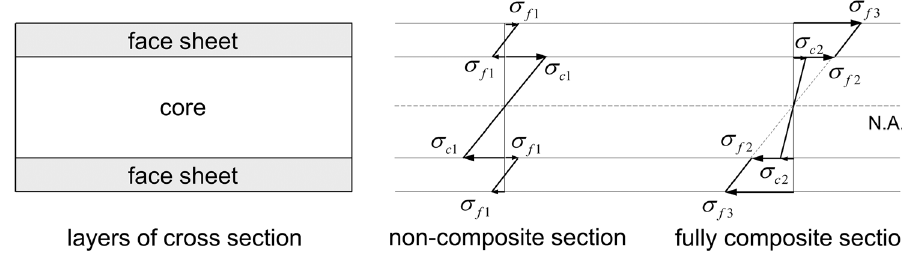
Fig. 9 Stress distribution in a non-composite sandwich panel and fully composite sandwich